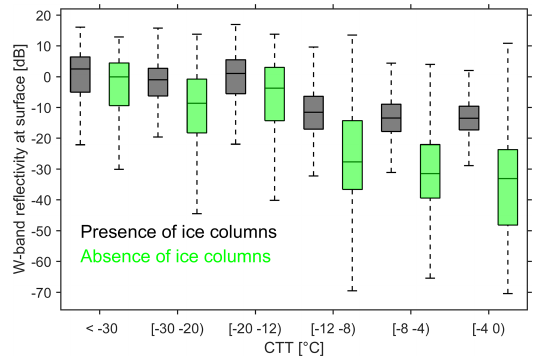
Figure 4. Comparison of liquid water path (LWP) for clouds with and without columnar-ice production. A cloud sample was identi- fied if the cloud base was within the temperature range of − 10 to 0 ◦ C. The box plots represent the median (horizontal strip) and 5%– 95% quantile (whisker) ranges of the distribution.